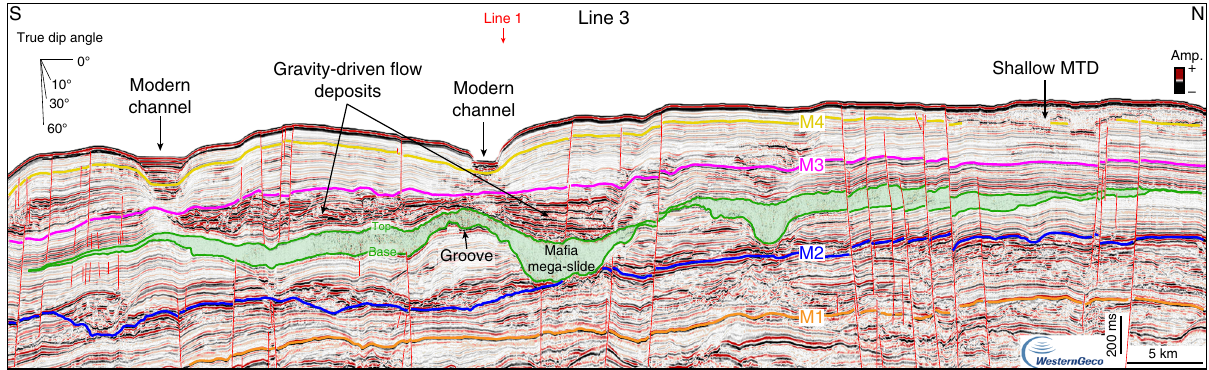
Fig. 5 Seismic line showing the along-strike variability of the Ma fi a mega-slide and bounding deposits. Seismic Line 3, oriented N – S and intersecting seismic Line 1 (red arrow), shows continuous to discontinuous and high-amplitude re fl ections between the top of the Ma fi a mega-slide and horizon M3, that are interpreted as coarse-grained gravity-driven fl ow deposits. MTD: mass-transport deposit. Noninterpreted version of Line 3 is available in the Supplementary Fig. 6.